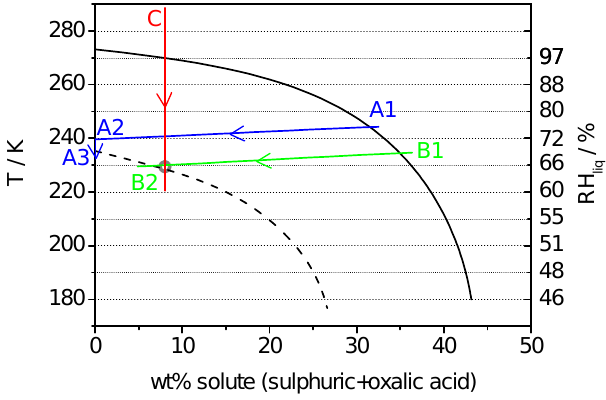
Fig. 1. Schematic experimental trajectories of various ice nucle- ation experiments with supercooled aqueous sulphuric/oxalic acid solution droplets in the temperature – composition plane, adapted from Wagner et al. (2010). The abscissa denotes the total solute concentration (wt% sulphuric acid+wt% oxalic acid). The ice melting-point curve, shown as the black line, was calculated for an oxalic acid to sulphuric acid mass ratio of 1.14:5 with the Extended AIM Aerosol Thermodynamics Model II (Clegg et al., 1998; Clegg and Seinfeld, 2006a, b). The right y-axis denotes the prevailing relative humidity with respect to supercooled water, RH liq , for an environment that is saturated with respect to ice, i.e., when mov- ing on the ice-melting point curve in the phase diagram. The red trajectory corresponds to the freezing experiment with emulsified solution droplets of 4wt% sulphuric acid and 4wt% oxalic acid by Zobrist et al. (2006) which homogeneously froze at 229.4K in the first cooling cycle, as indicated by the grey circle. In lack of fur- ther freezing temperature measurements for different compositions in the ternary system, the dashed black line denotes the critical ice nucleation temperatures as a function of solute concentration for pure sulphuric acid solution droplets from the study by Koop et al. (1998). The blue and green trajectories represent expansion cool- ing experiments with airborne particles in the AIDA cloud chamber, see text for